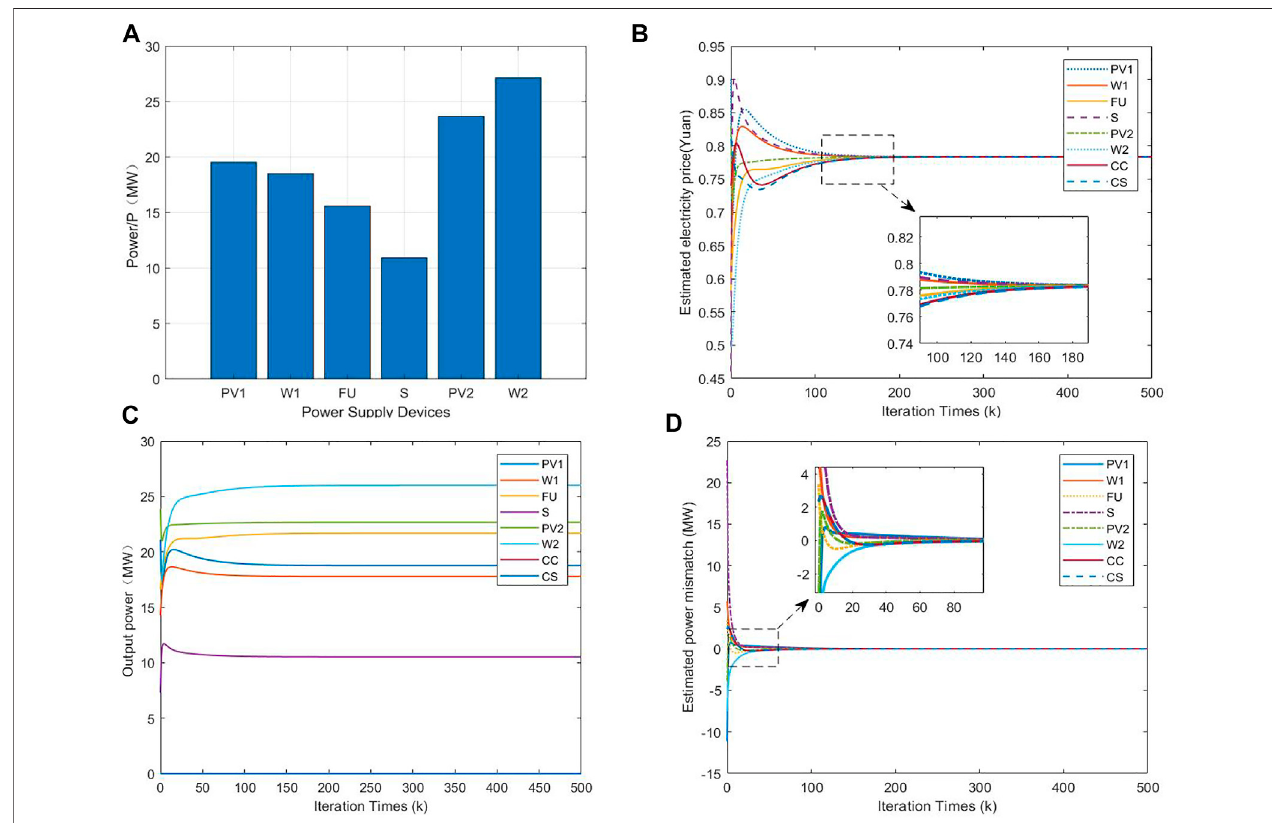
FIGURE7| Simulationresultsinislandmode. (A) istheresultsofcentralizedalgorithm, (B) isthedynamiccurveoftheelectricityprice λ , (C) isthedynamiccurveof the power output, (D) is the dynamic curve of estimated power.